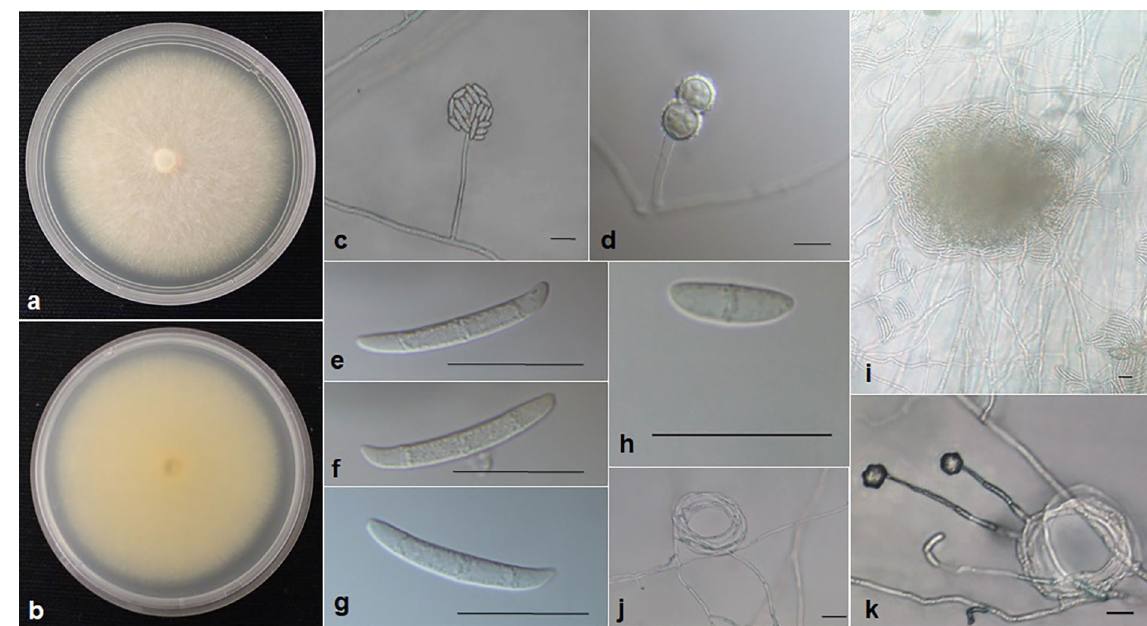
Figure 4. Fusarium crassum , ( a ) Colony on PDA and ( b ) reverse side after 7 days incubation at 26 ± 1 °C. ( c ) areal mycelia presenting microconidia in false heads in situ, ( d ) Chlamydospores with rough walls in situ , ( e – g ) macroconidia, ( h ) microconidia with one septa, ( i ) macroconidia in situ on carnation leaf agar after 21 days incubation at 26 ± 1 °C, ( j – k ) hyphal coils observed in situ on carnation leaf agar. All scale bars = 20